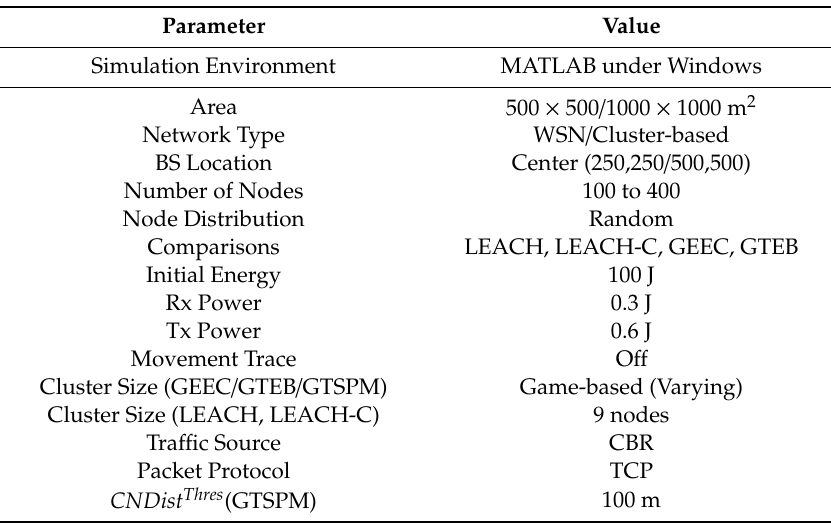
Table 6. List of parameters.